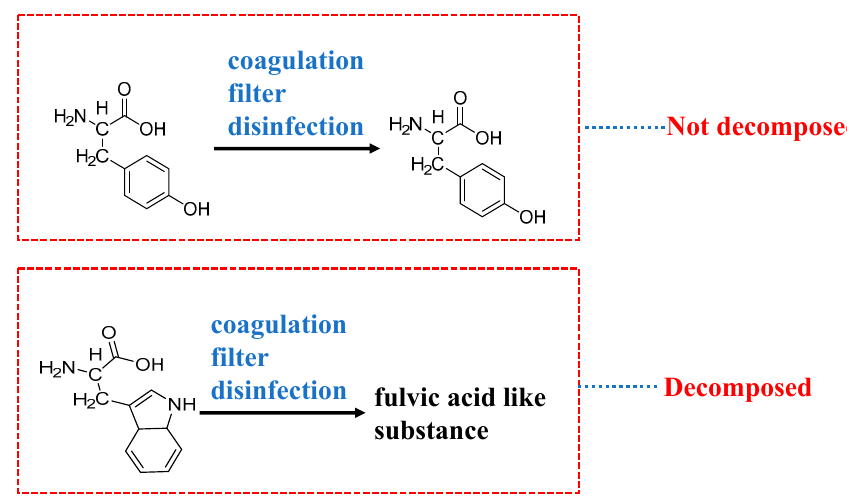
Figure 9. Schematic diagram of DOM removal in mine water.